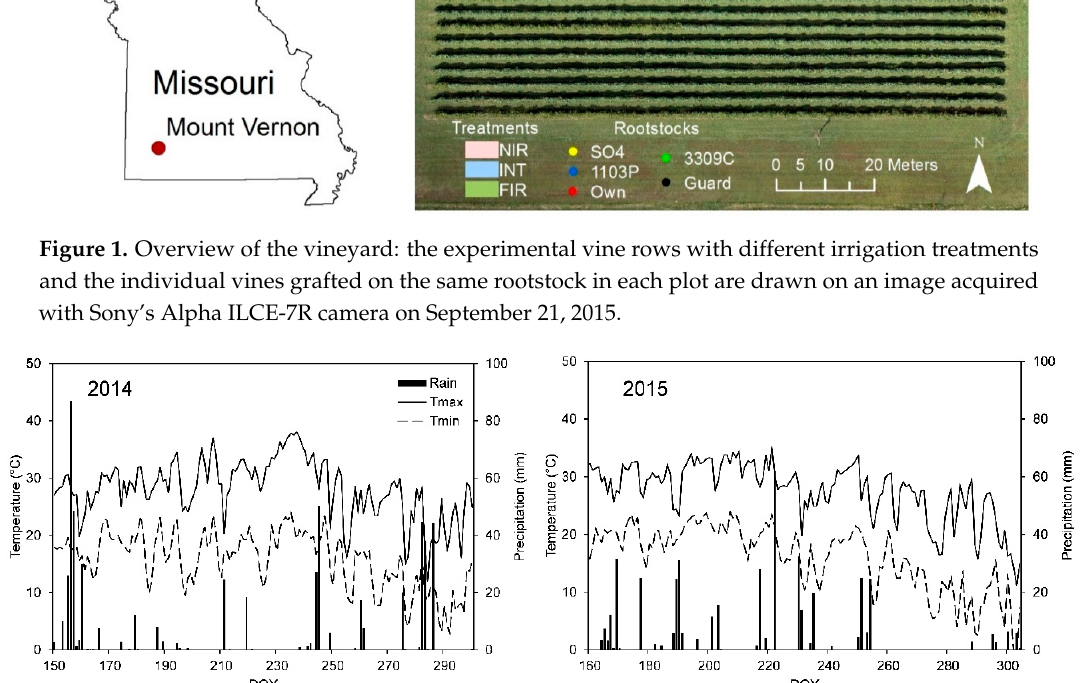
Figure 2. Daily average minimum (Tmin, °C), maximum air temperature (Tmax, °C) and amount of daily precipitation (mm) events (modified from Maimaitiyiming et al. [42]).